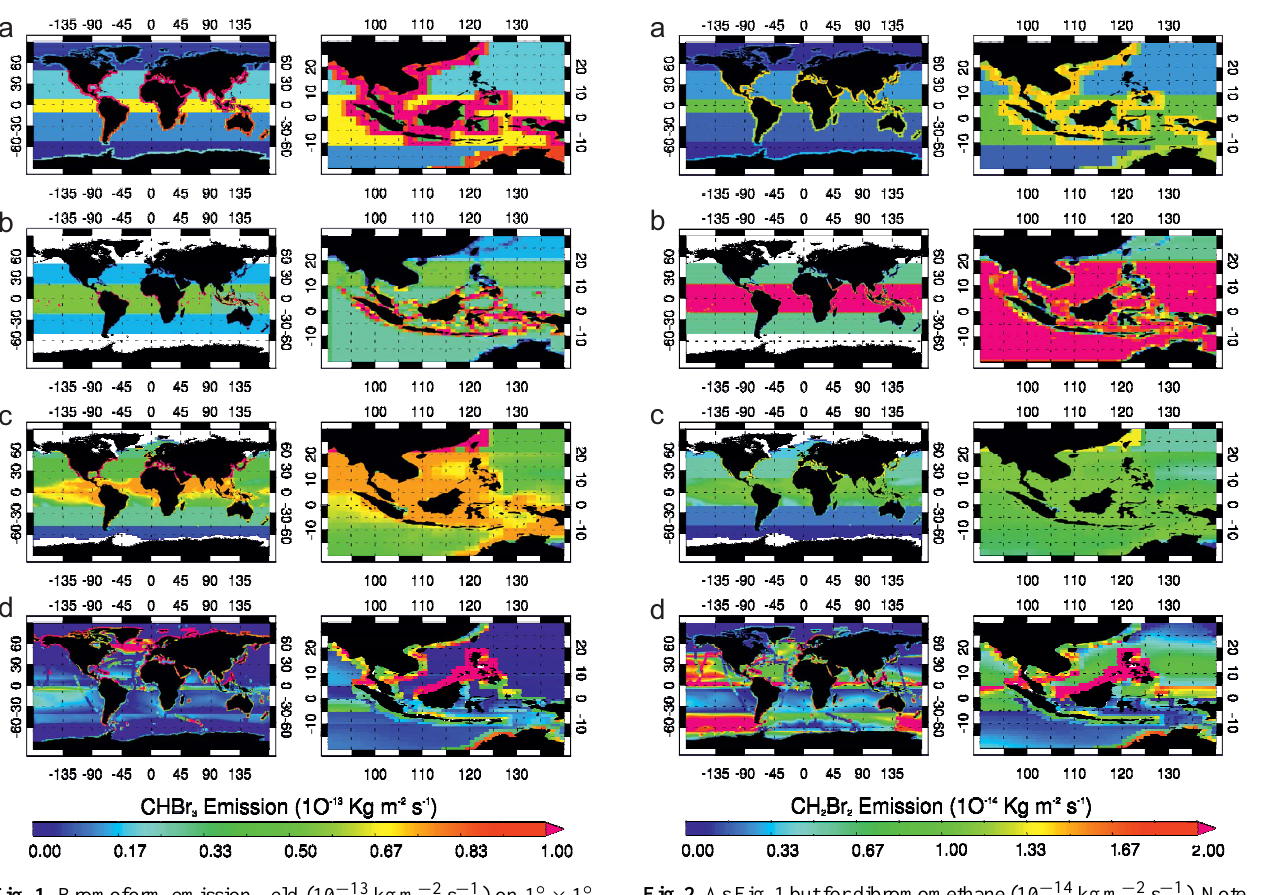
Fig. 1. Bromoform emission field (10 − 13 kgm − 2 s − 1 ) on 1 ◦ × 1 ◦ grid for global (left) and western Pacific (right) regions. Emissions from the (a) Liang-2010, (b) Warwick-2011, (c) Ordóñez-2012 and (d) Ziska-2013 scenarios.